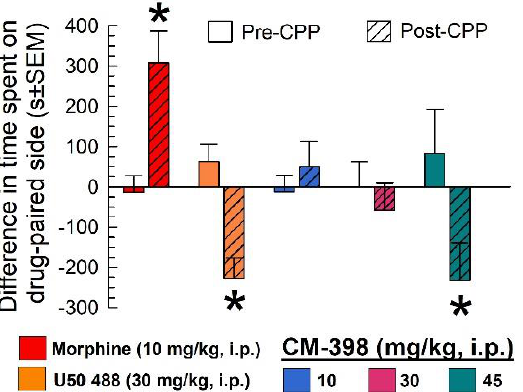
Figure 8. Evaluation of CM-398 in the conditioned place preference assay. While mice showed pref- erence for the chamber paired with morphine treatment (10 mg/kg, i.p.), and aversion for the kappa agonist, U50,488 (30 mg/kg, i.p.), no preference or aversion was seen for CM-398 at 10 and 30 mg/kg, i.p. However, CM-398 at 45 mg/kg, i.p. showed significant conditioned place aversion. For each group, n = 14 – 24; * = postconditioning response (striped bars) significantly different from matching pre-CPP response (matching open bars), p< 0.05; two- way ANOVA with Sidak’s post hoc test.